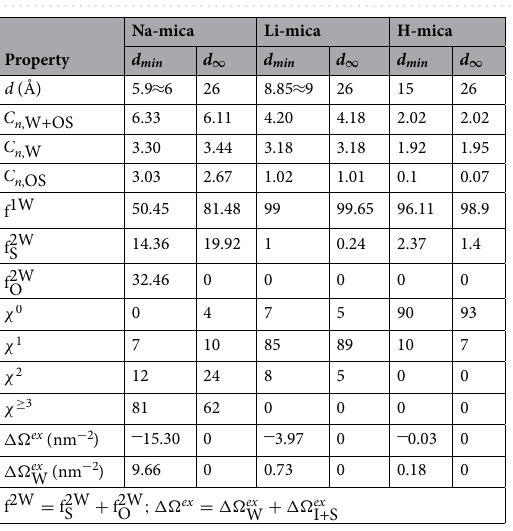
Figure 8. Thermodynamics of clay swelling due to water adsorption in ( a , b ) Na-mica, ( c , d ) Li-mica and ( e , f ) H-mica pores. (Top row) Profiles of disjoining pressure ( (cid:31) , in kbar) and swelling free energy ( (cid:31)(cid:30) ex , in nm − 2 ) in M-mica systems. With increase in hydration energy of cations from Na + to H + ion, the (cid:31)(cid:30) ex progressively becomes replusive thus favouring swelling. (Bottom row) Individual contribution to (cid:31)(cid:30) ex from confined water ex (cid:31)(cid:30) ex ex for d ≥ 11 Å arises due to fluctuations ( (cid:31)(cid:30) I+S ). The long tail in (cid:31)(cid:30) W ) and cation + mica framework ( in (cid:31) which can be assumed to be zero (i.e., �( d ≥ 11Å ) = 0 ). All values of (cid:31)(cid:30) ex (individual contribution and total) were normalized by thermal energy ( k B T ) and A xy of mica surface used, thus has units of nm − 2 . The numerical value represent the energy required to separate clays of unit area (of nm 2 ) compared to thermal energy.